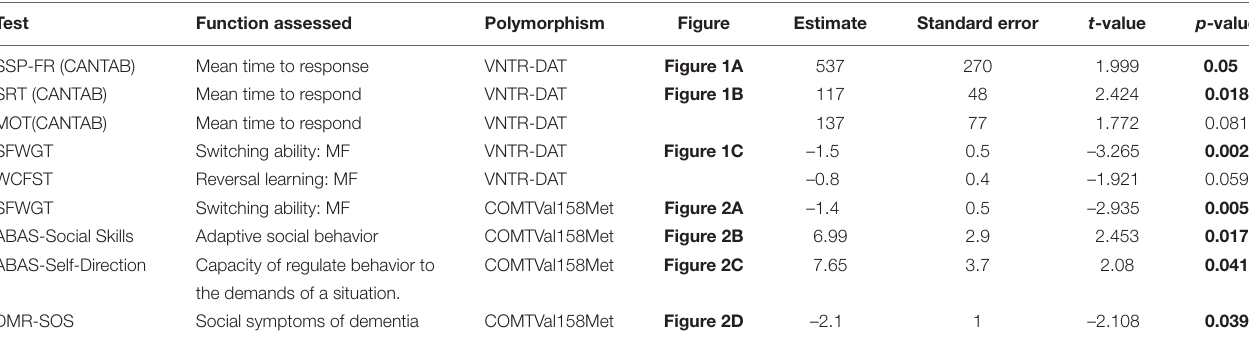
TABLE 2 | VNTR-DAT1 and COMTVal158Met effects on cognitive and functional variables in the TESDAD DS